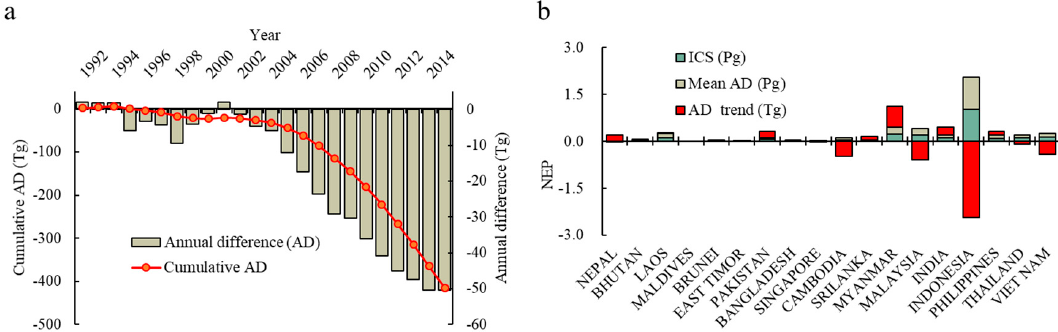
Figure 4. Dynamics of annual differences (AD) and cumulative AD over year ( a ); and the statistical information of AD and ICS in various countries ( b ).